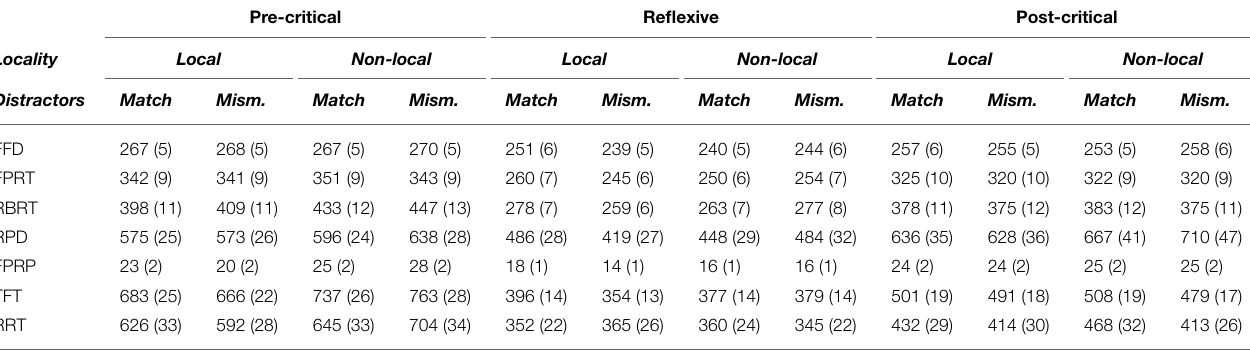
TABLE 8 | Experiment 2: Means and standard errors of raw first-fixation duration, first-pass reading time, right-bounded reading time, regression-path duration, total fixation time, re-reading time in ms, and first-pass regression probability in percentages at the pre-critical region, the reflexive and the post-critical